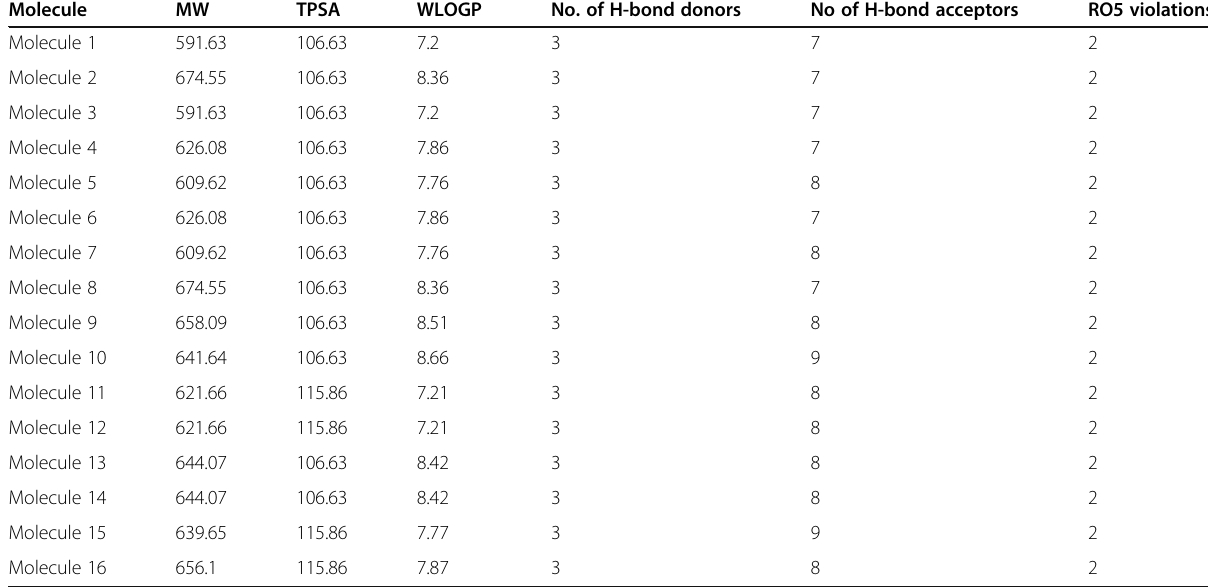
Table 6 Drug-likeness properties of the newly designed compounds Molecule